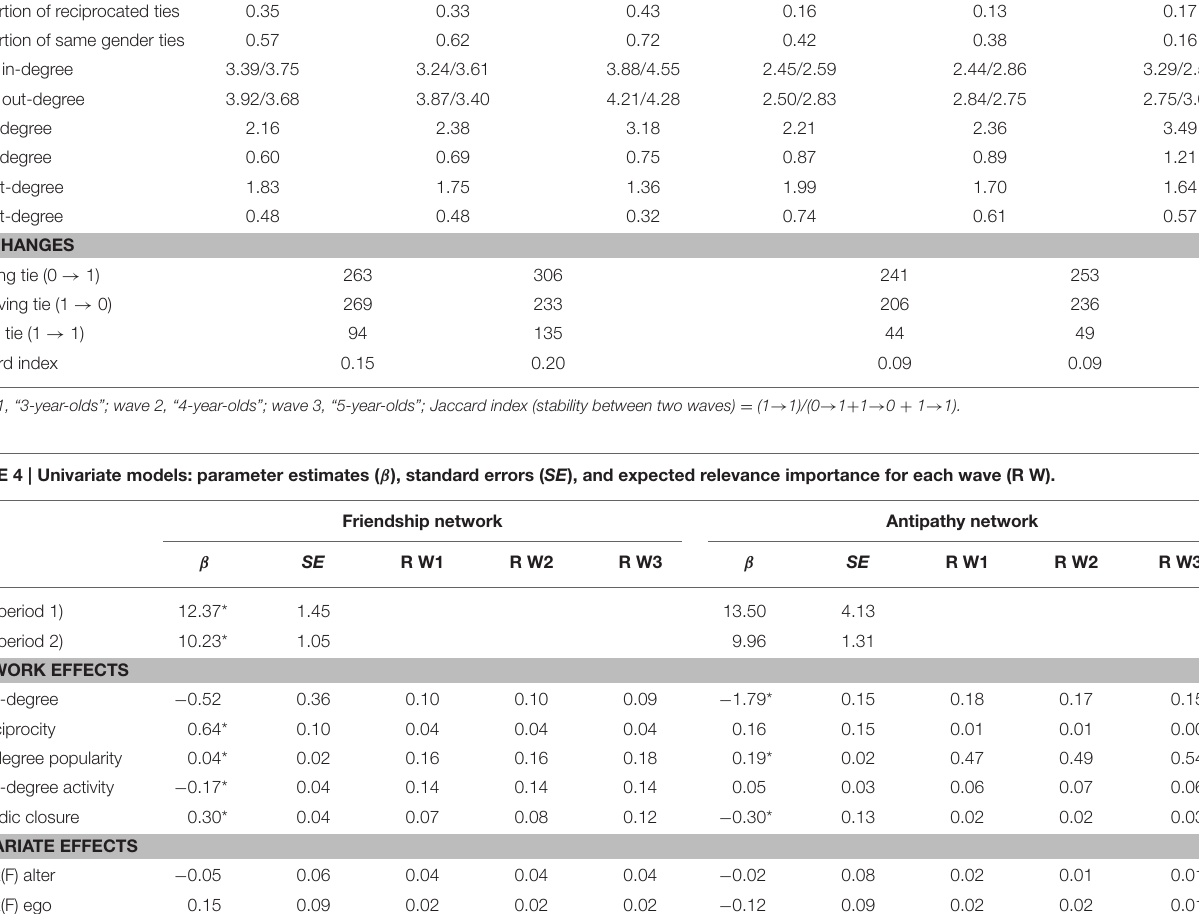
Friendship network